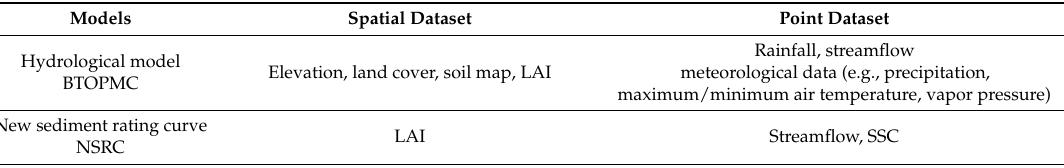
Table 1. Dataset summary for different models in the